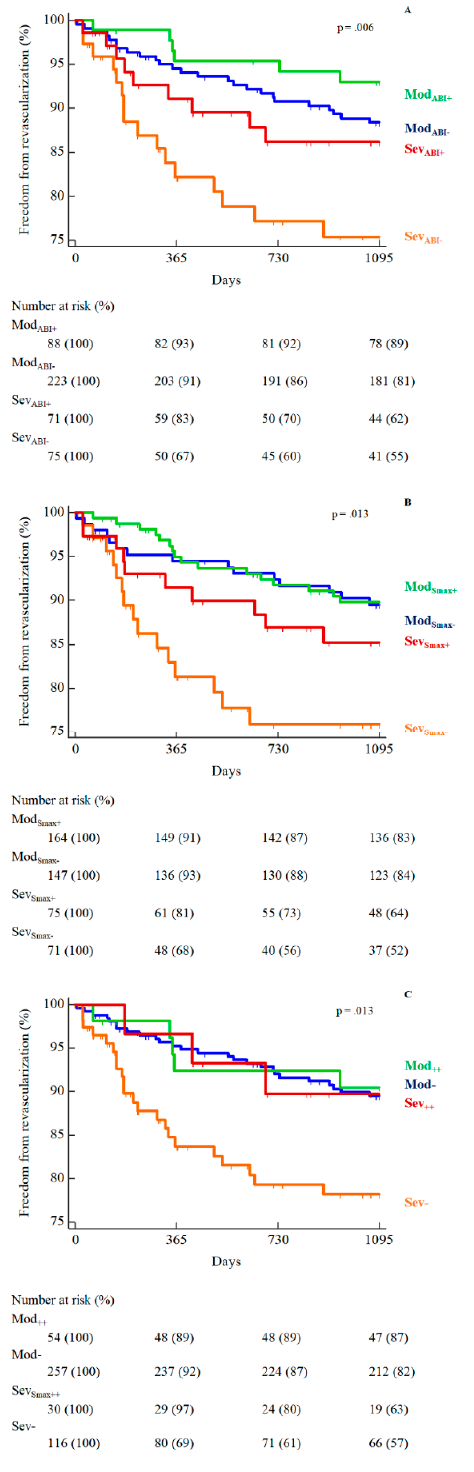
Figure 2. Kaplan-Meier curves of revascularizations in the four patients’ subgroups according to disease severity and ABI ( A ), or maximal speed improvements ( B ), or both ( C ).